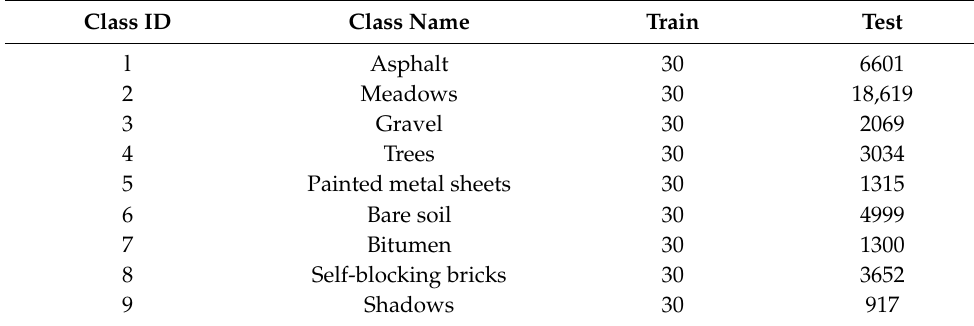
Table 2. Number of training and test sets for the University of Pavia dataset.